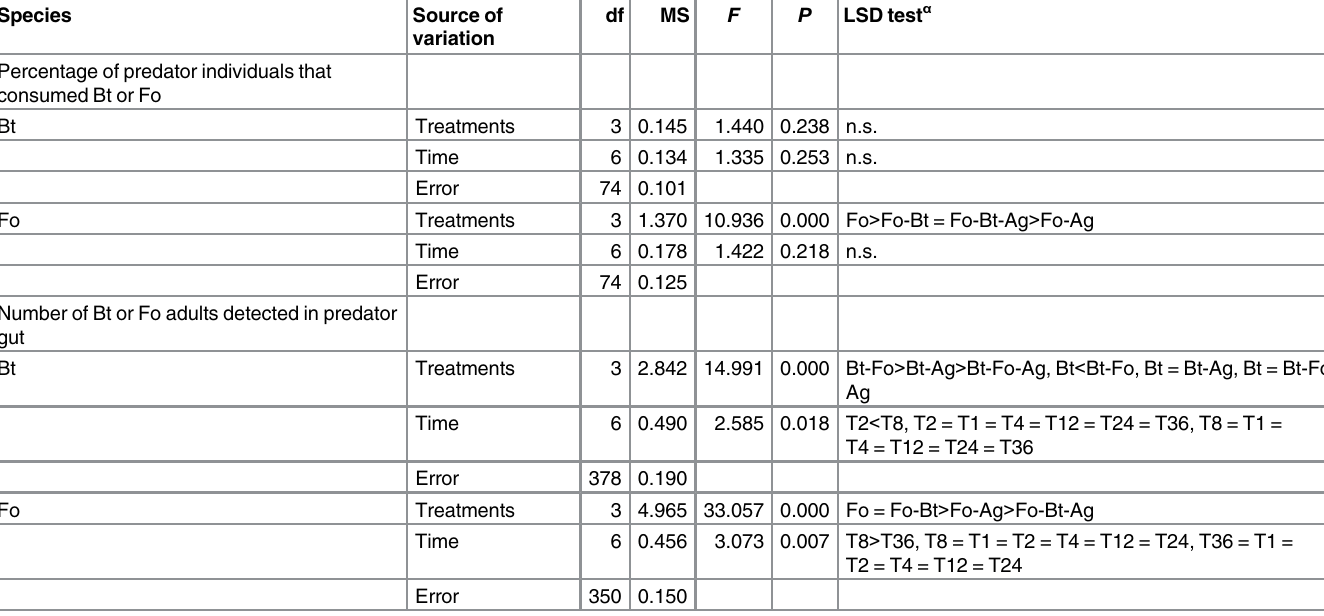
Table 2. Two-way ANOVA (treatment and time after predator release) to compare the percentage of predation and number of prey adults con- sumed by Harmonia axyridis on Bemisia tabaci (Bt) or Frankliniella occidentalis (Fo).